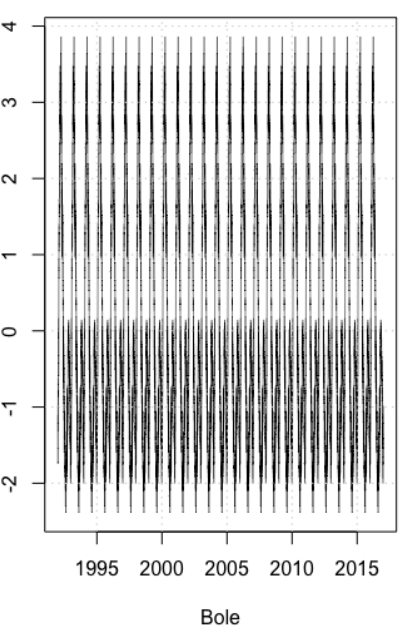
Figure 3. Seasonal trend of the daily average temperature for Bole and Tamale.